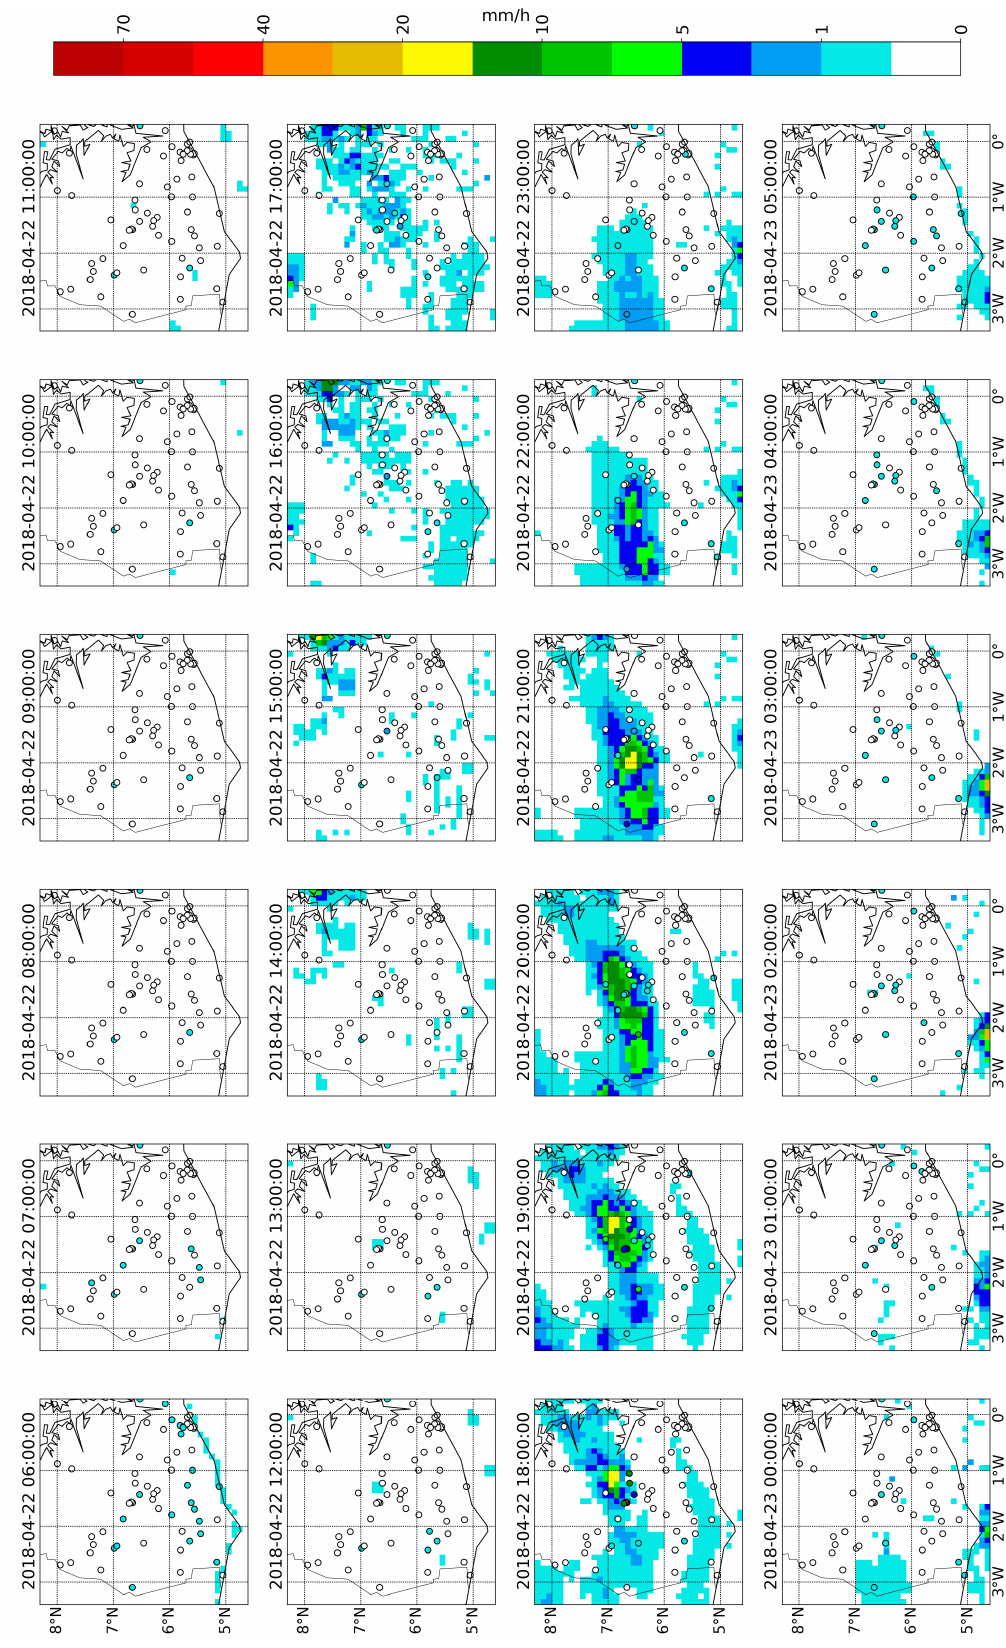
Figure 5. Input data for the southern Ghana case. IMERG-Late (background) and TAHMO (circle) 1 h accumulated rainfall from 06:00 22 April to 06:00 23 April